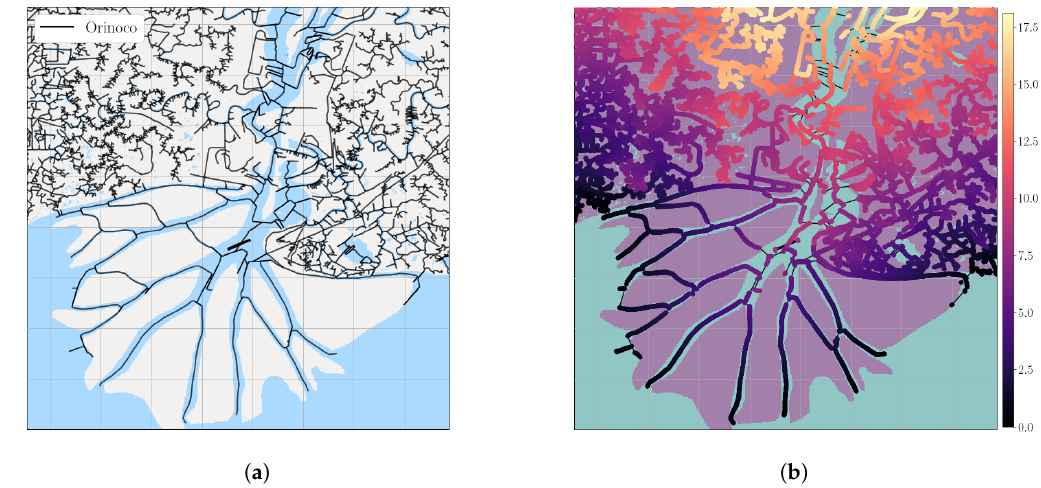
Figure 3. Using Google map tiles, we select water areas to create a 2 m water mask over the Wax Lake Delta. Panel ( a ) shows the channel centerlines and panel ( b ) are the nodes colored by their distance to the ocean according to the network